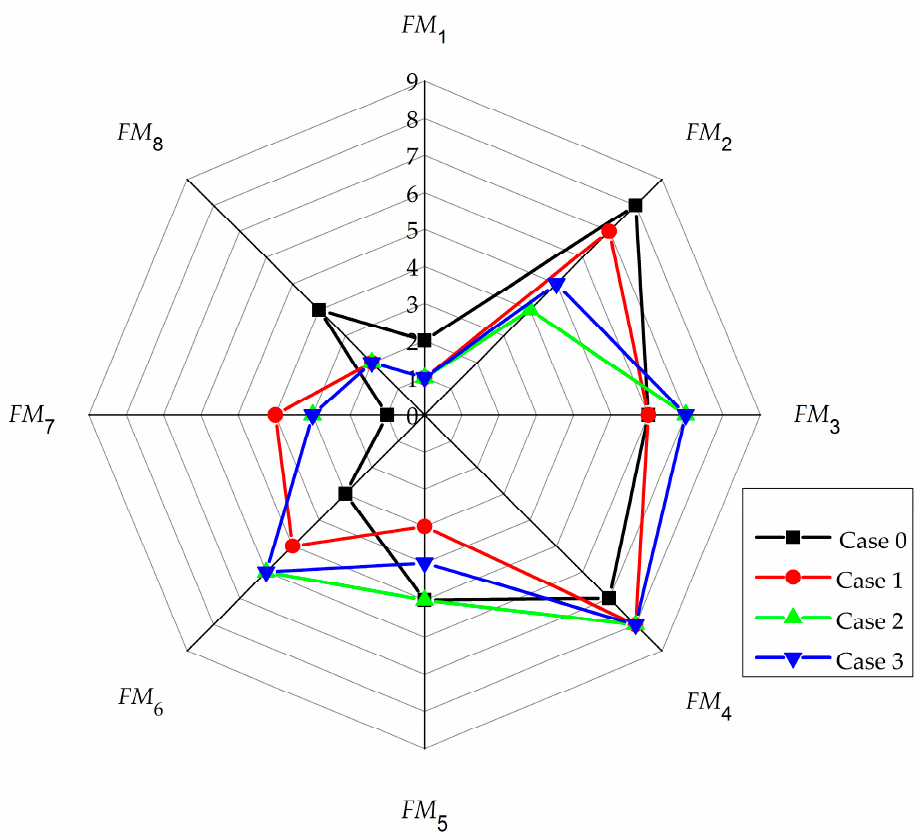
Figure 2. The ranking results of the sensitivity analysis.